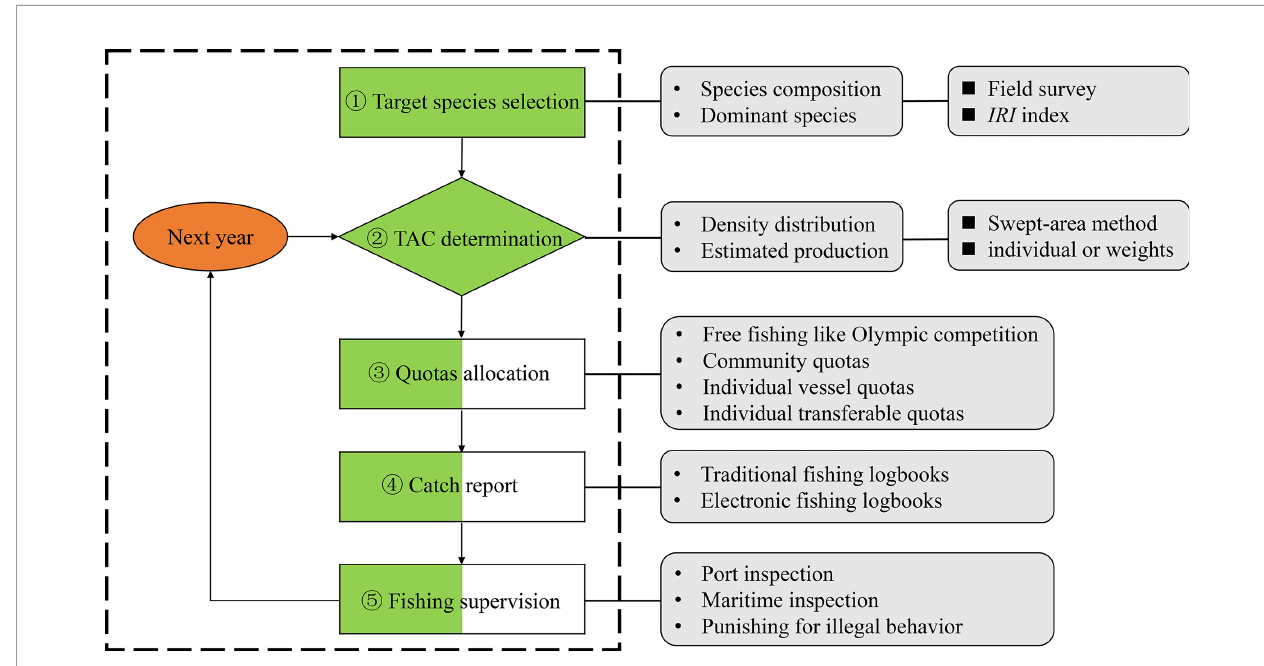
FIGURE 4 | The frame improvement of the bivalve FQ system and current perform status (the fi lled green color represents the degree of completion,